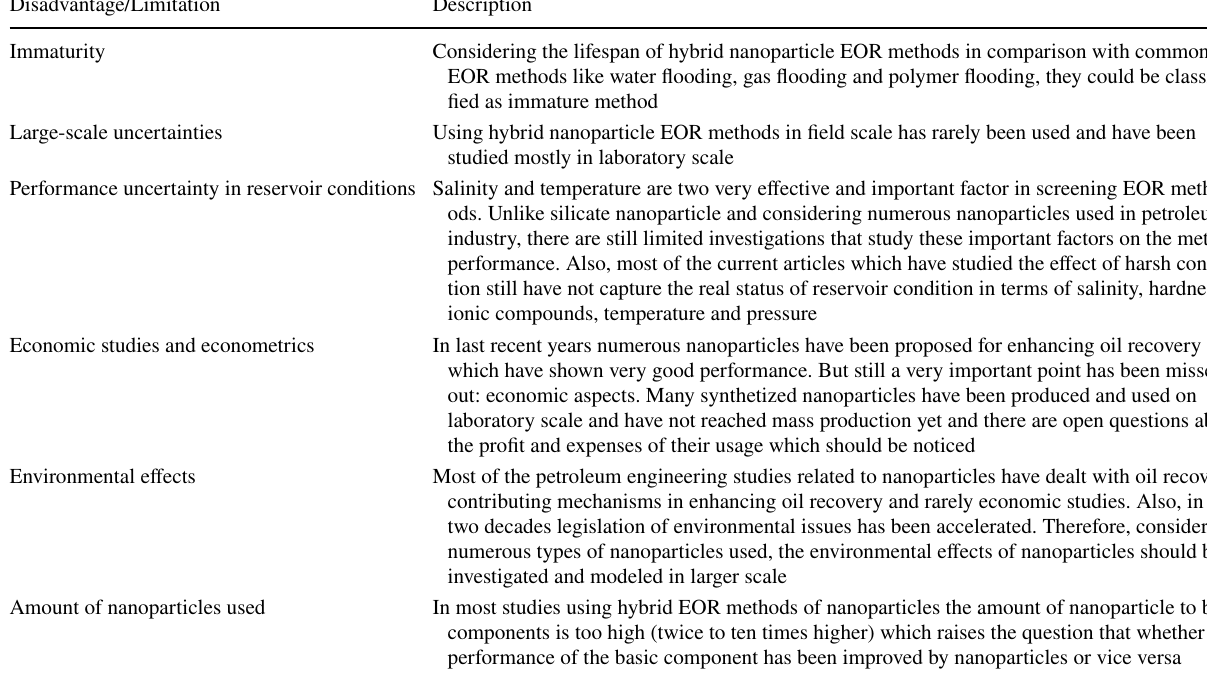
Table 4 Disadvantage/limitations of using hybrid of NPs and EOR methods